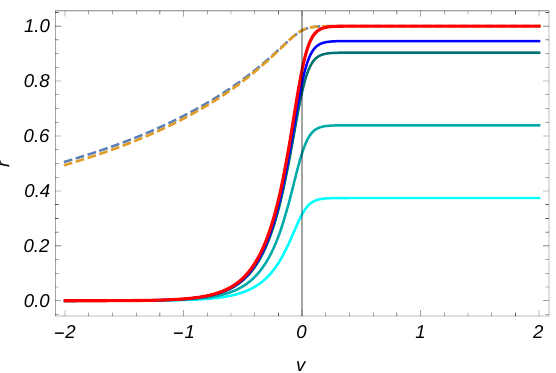
Figure 1 . The dashed lines are the event horizons for (cid:21) GB = 0 : 05 ; (cid:0) 0 : 05 The red line is the apparent horizon which is independent of (cid:21) GB and the other lines are the singularity for di(cid:11)erent values of (cid:21) GB = (cid:0) : 0 : 005 ; (cid:0) 0 : 05 ; (cid:0) : 5 ; (cid:0) 1 : from bottom to top respectively. We have used m ( v ) = (cid:0) (cid:0) v (cid:1)(cid:1) 1 1 + tanh 2 0 : 1